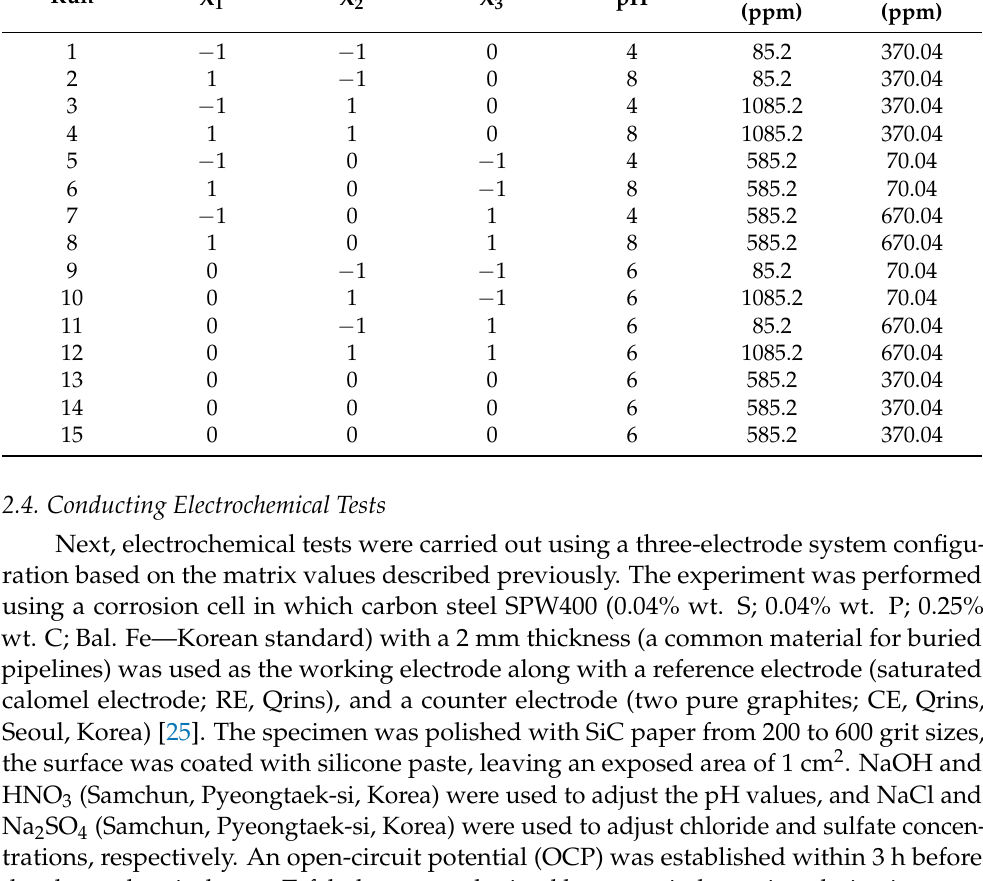
Table 3. Experimental design based on the Box–Behnken Design matrix for the three variables.